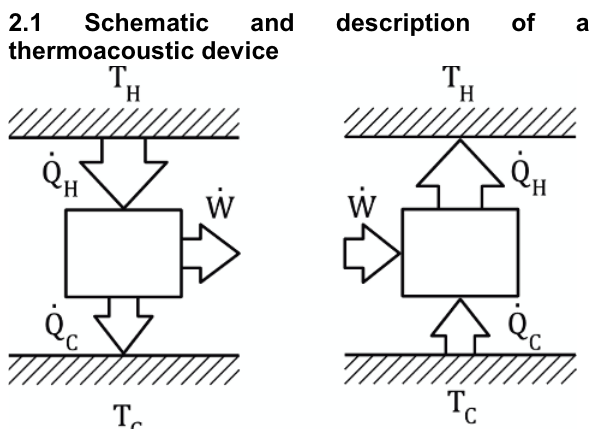
Figure 1. Schematic of function of thermoacoustic engine (left) and thermoacoustic heat pump